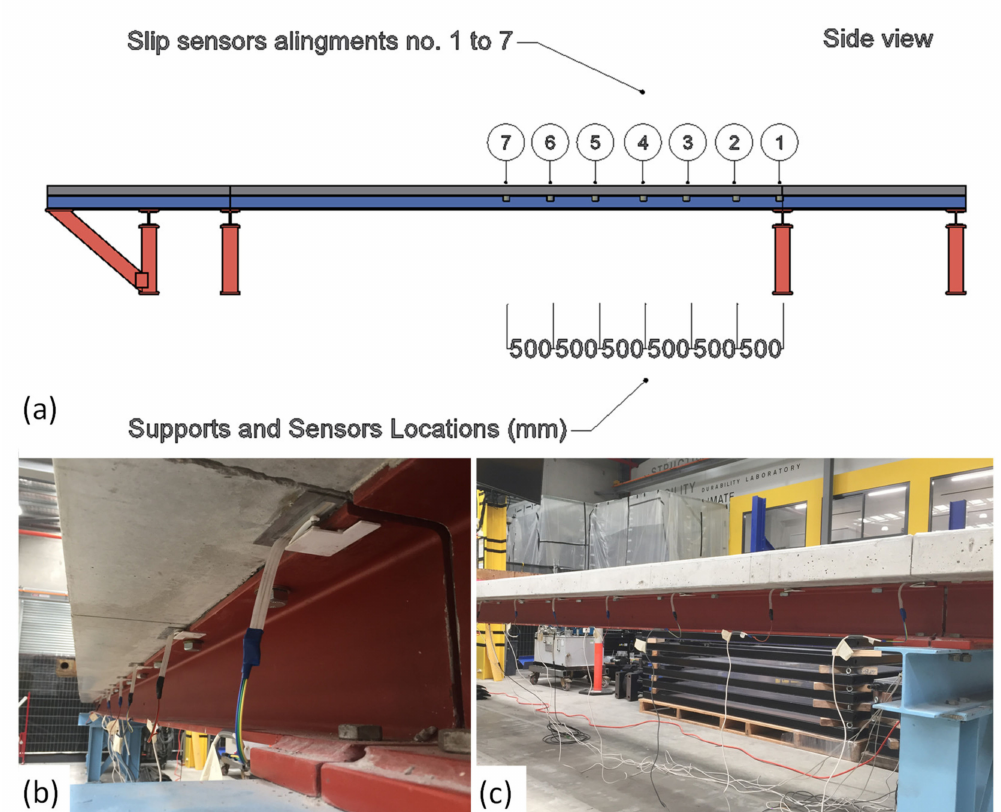
Figure 7. ( a ) Schematic to the bridge showing the sensors alignments and numbers, ( b ) the slip sensor location on the support and ( c ) the slip sensors locations on the half of a